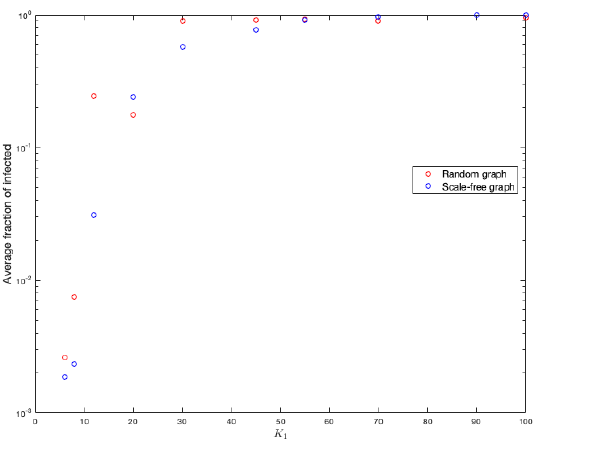
Figure 13. Average infected for the different values of K 1 in random and scale-free